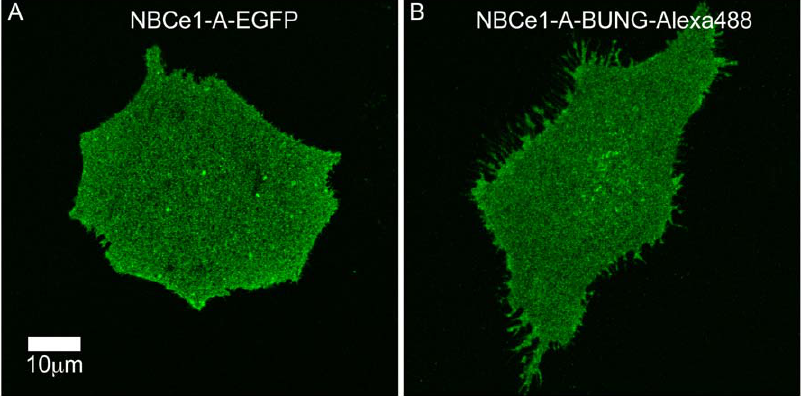
Figure 4. Sample CLSM images of CHO-K1 cells transiently transfected with NBCe1-A. (A) NBCe1-A-EGFP. (B) NBCe1-A- a -bungarotoxin mutant expressed in cells, and labeled with Alexa 488- a -bungarotoxin conjugate. In both cases, basal membranes of highly adherent cells was imaged. The cells were chemically fixed prior to imaging. The pixel size is 0.046 m m. The images were taken under the identical acquisition condition so that valid comparisons between different images could be made. The image contrast was enhanced in both panel A and B for visualization purposes.